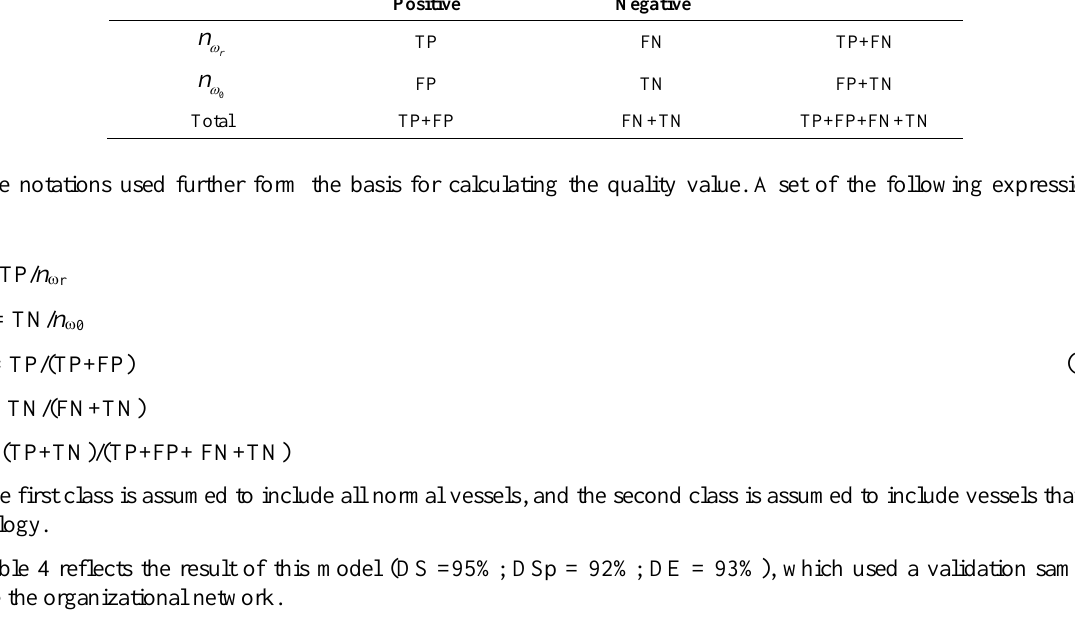
Table 4. Vascular diagnostic test